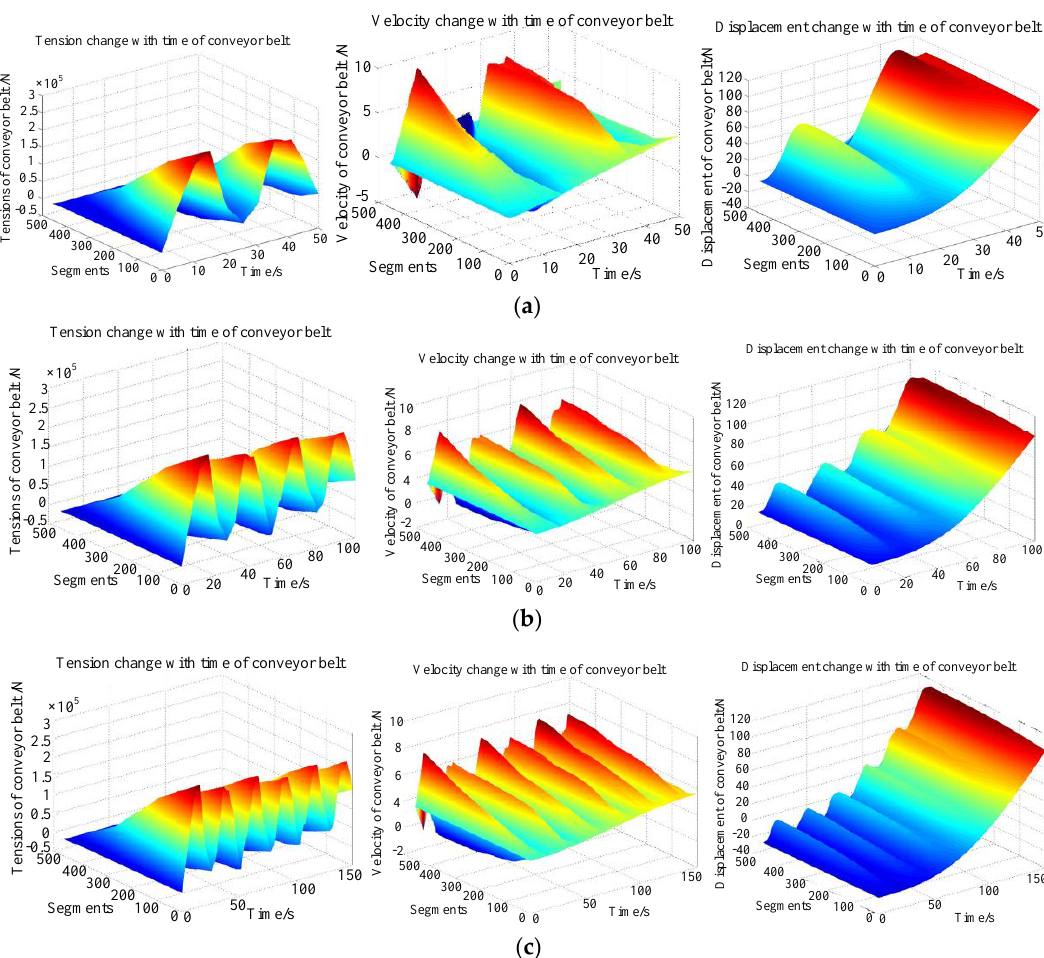
Figure 11. Dynamic characteristic curves of the belt conveyor under different starting times. ( a ) Starting time is 50 s. ( b ) Starting time 100 s. ( c ) Starting time 150 s. In Figure 11a, the soft-start control curve is the same, however the starting time is different. The longer the starting time, the less the starting acceleration of the conveyor belt. It is found that the probability of peak dynamic tension in the conveyor belt at the head and the tail of the machine is significantly reduced. It can be seen from the figures that the maximum tension on the conveyor belt presents a law of exponential decline as the starting time increases. When the starting time is less than 100 s, the peak value of the dynamic tension of the conveyor belt increases significantly, and the conveyor belt vibration is more severe. After prolonging the starting time, the dynamic characteristics of the conveyor belt are obviously improved.